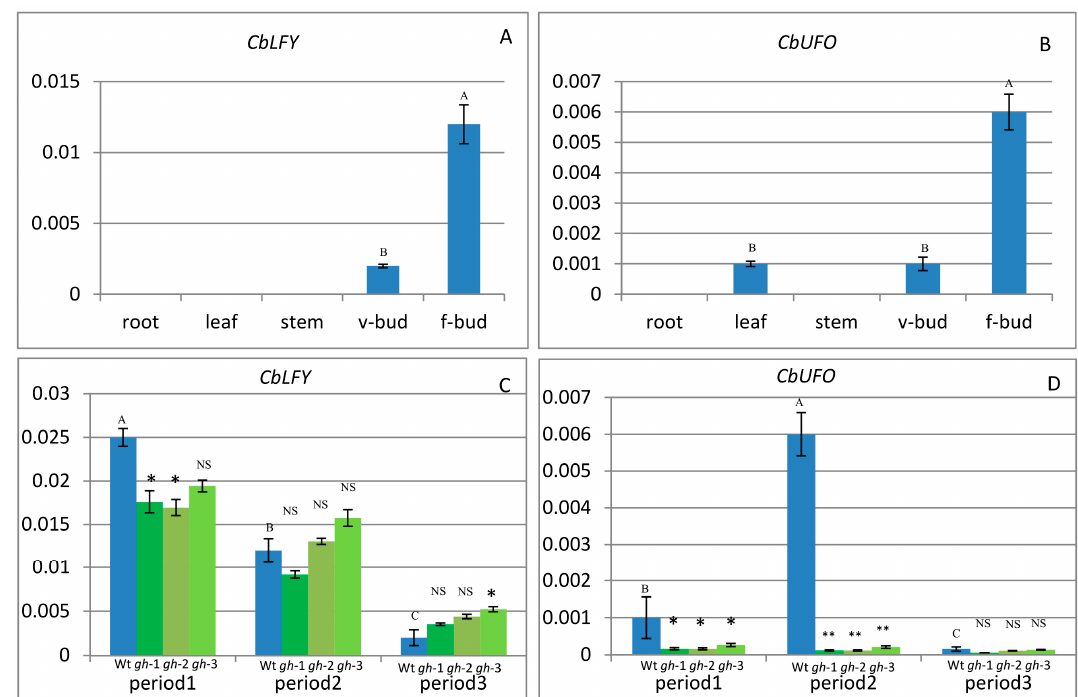
Figure 6. Expression of CbLFY and CbUFO in wild-type and gh cosmos. ( A ) Expression of CbLFY in different organs of wild-type cosmos; ( B ) expression of CbUFO in different organs of wild-type cosmos; ( C ) expression of CbLFY in different stages of wild-type cosmos (the left bar) and “green head” cosmos (the right three bars; gh-1, gh-2, gh-3); ( D ) expression of CbUFO in different stages of wild-type cosmos (the left bar) and “green head” cosmos (the right three bars; gh-1, gh-2, gh-3). Each value was the average of three different samples. Mean values with the same capital letter indicate no significant difference ( p > 0.05). Each value represents the mean from three biological replicates; * indicates significantly different at 0.05 level; ** indicates significantly different at 0.01 level; NS indicates no significant difference ( p > 0.05); v-bud = vegetable bud; f-bud = flower bud.